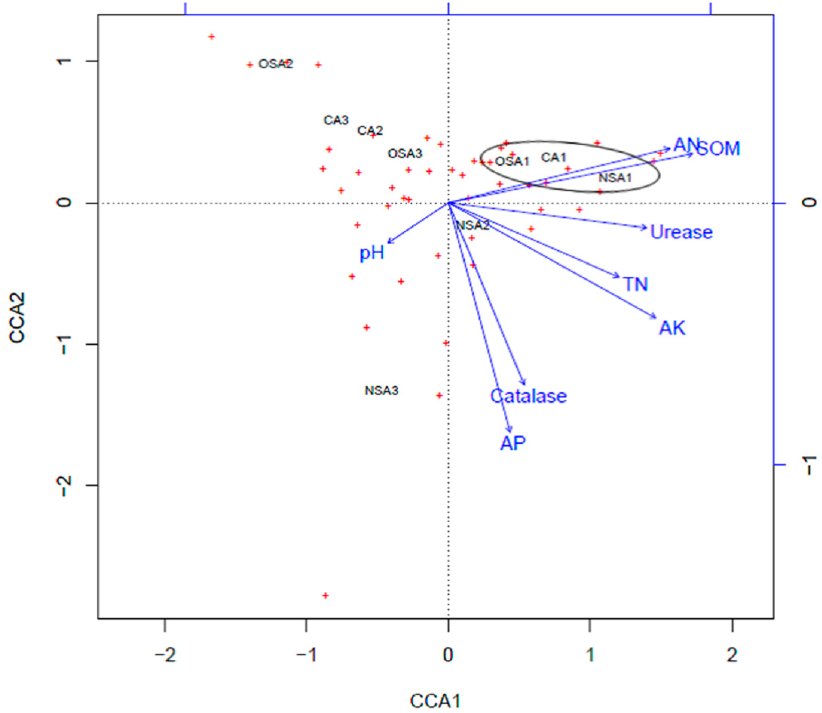
Figure5. Canonicalcorrelationanalysis(CCA)ordinationofbacteriacommunitywiththeenvironmental Figure 5. Canonical correlation analysis (CCA) ordination of bacteria community with the Int. J. Environ. Res. Public Health 2019 , 16 , x factors in the soils. environmental factors in the soils.